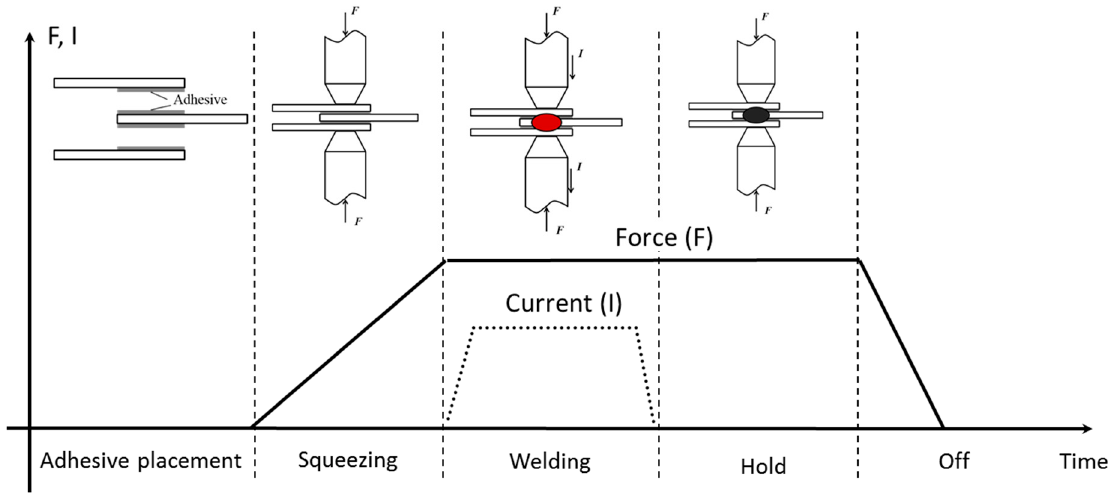
Figure 1. Chart for the weld-bonding process with three-sheets stacks.